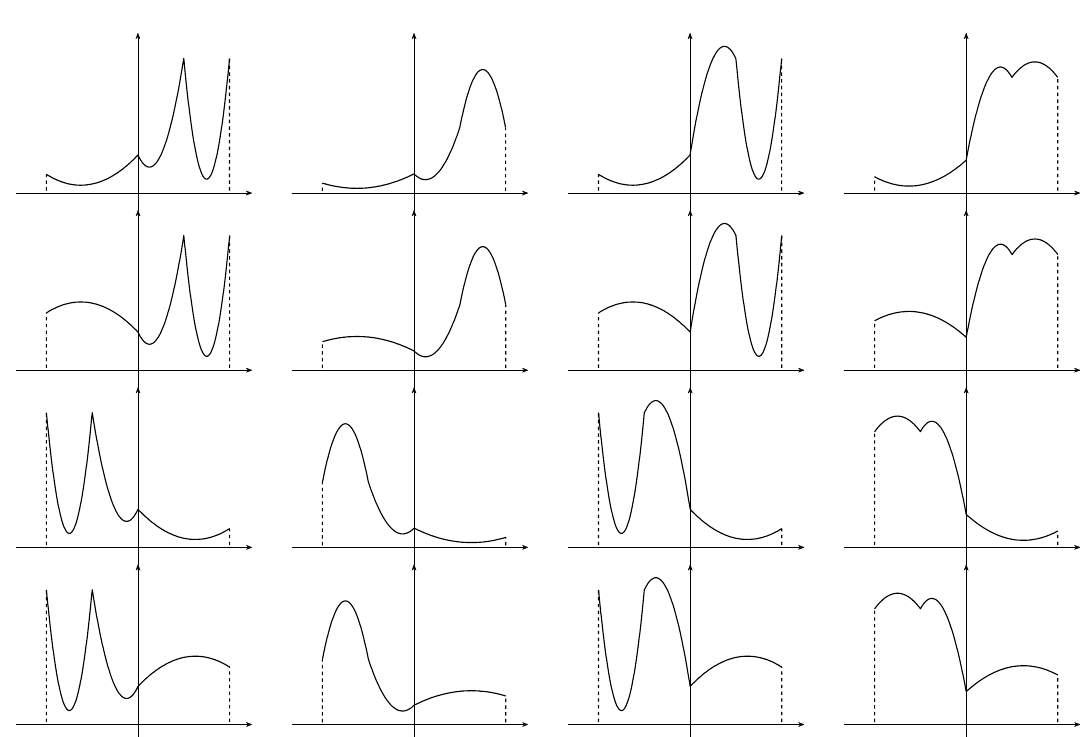
Figure 7. All possible scenarios of the piecewise quadratic function.